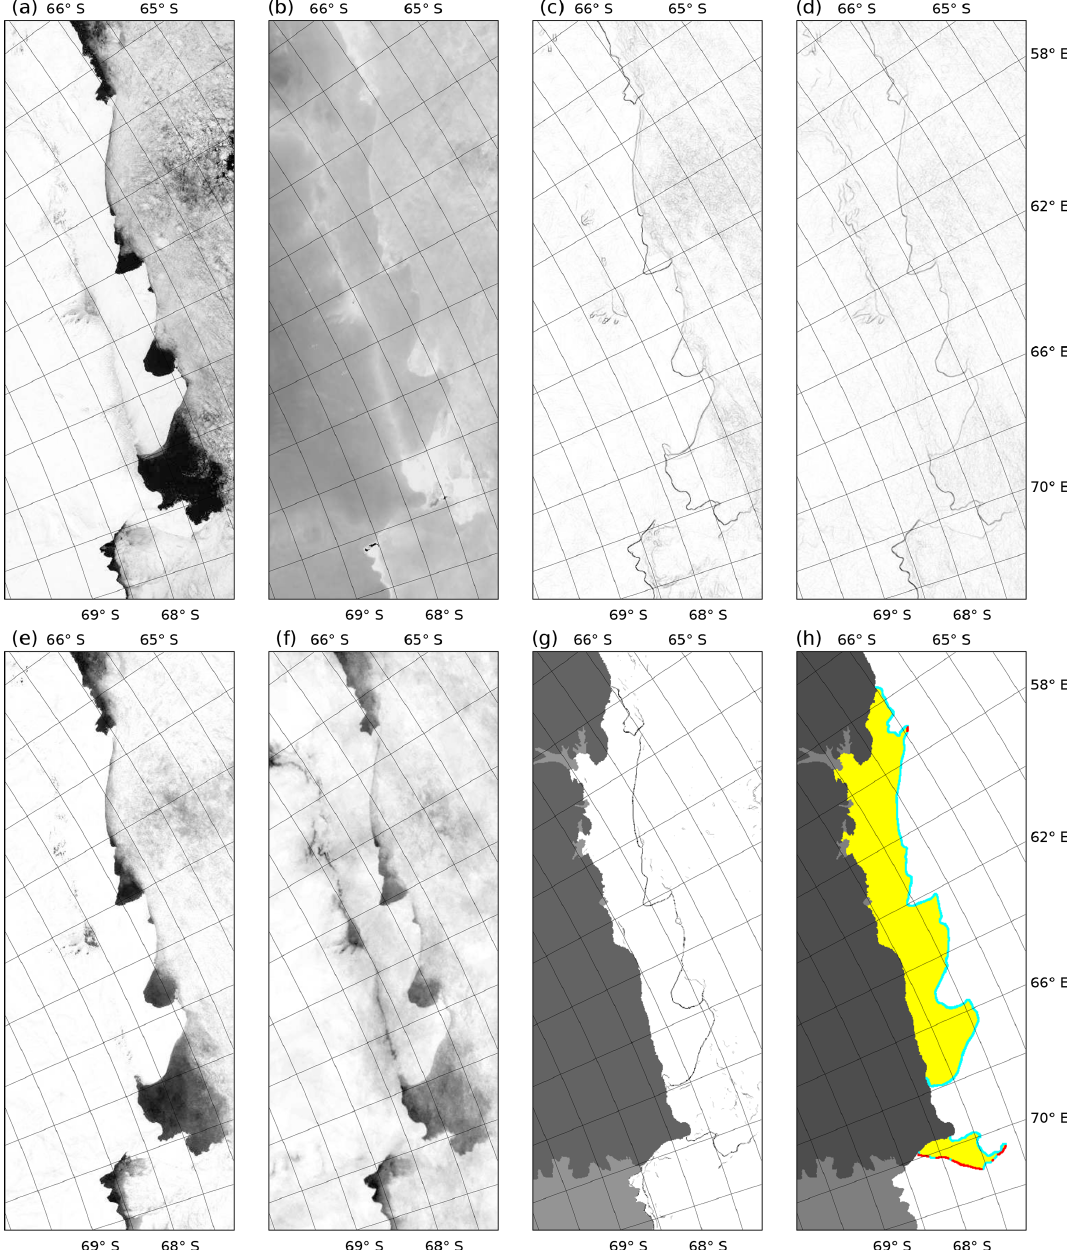
Figure 2. Figure depicting an example of the automated fast-ice edge detection along the Mawson Coast, East Antarctica, for DOY range 316–330, 2005. See the red rectangle in Fig. 3 for spatial context. (a, b) The 15d channel 1 (visible) and channel 31 (thermal infrared) cloud-free composite images, respectively. (c, d) Sum of Canny algorithm-detected edges in individual channel 1 and channel 31 images, respectively, for the 15d period. (e, f) Modified lead detection for channel 1 and channel 31 images, respectively (after Willmes and Heine- mann, 2015, but with an enlarged filtering window to enhance fast-ice detection). (g) Results of the combined edge detection algorithm (black line). Light and dark grey areas represent grounded and floating glacial ice, respectively, and are masked out. (h) Fast-ice classified map after manual edge inspection/correction and filling. Cyan and red represent automatically and manually completed edges, respectively, and the width of these lines has been expanded in this example to enhance visibility. Yellow represents infilled fast-ice